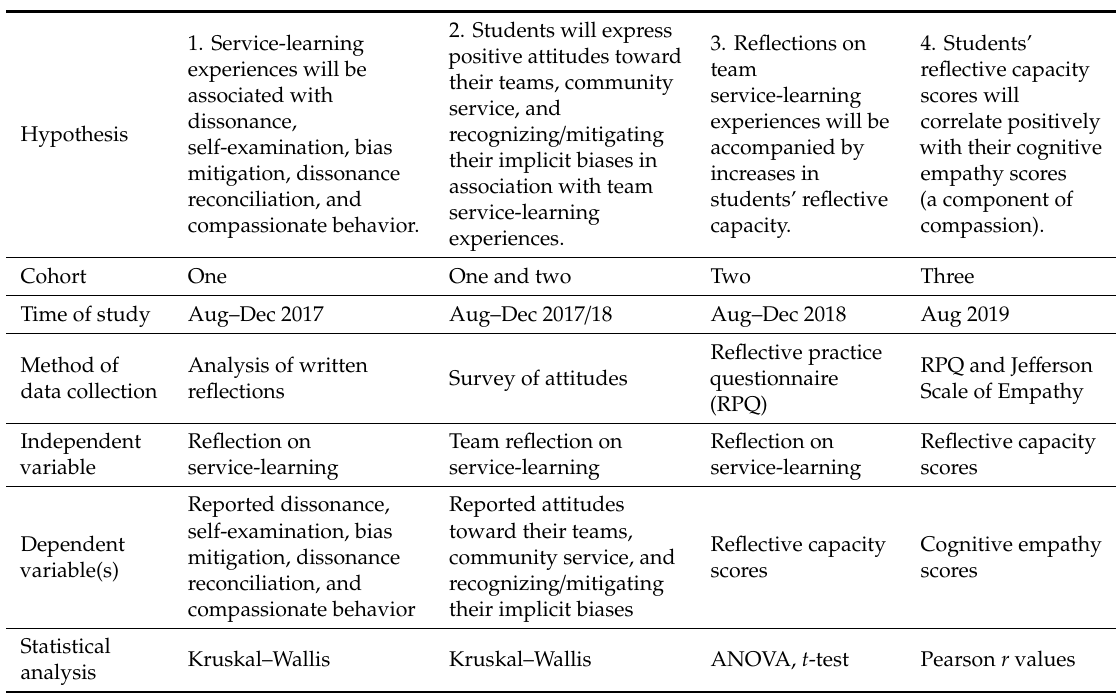
Table 2. Summary of